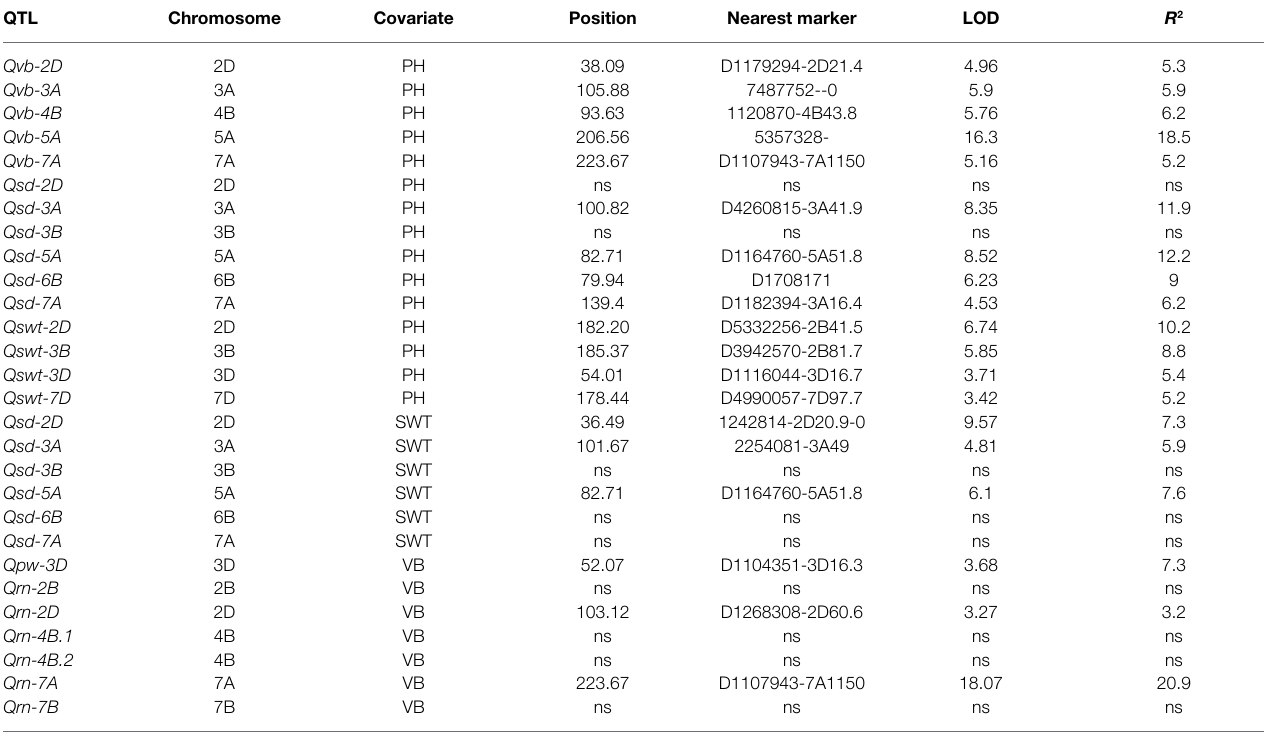
TABLE 4 | Changes in the significance and percentage variation determined by the QTL after PH or SWT/VB were used as covariates. QTL Chromosome Covariate Position Nearest marker